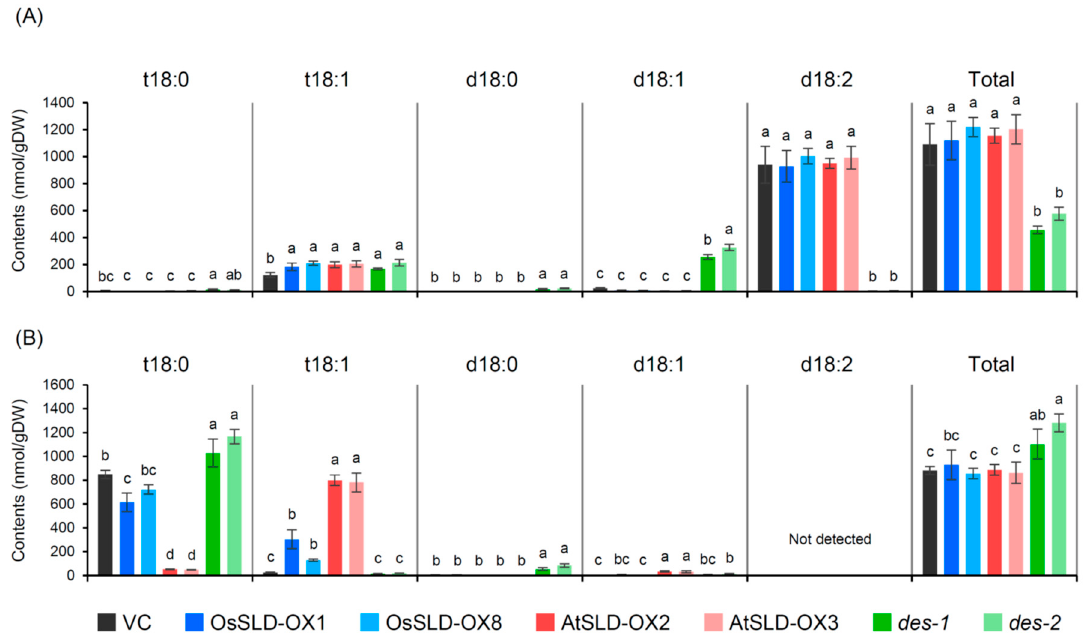
Figure 4. Sphingolipidomic characterization of transgenic rice plants. LCB profiles and total contents of ( A ) glucosylceramide (GlcCer) and ( B ) glycosylinositolphosphoceramide (GIPC). Data are means ± SDs ( n = 3–4). Different letters indicate statistical significance (Tukey’s HSD, P < 0.05). VC, vector control.